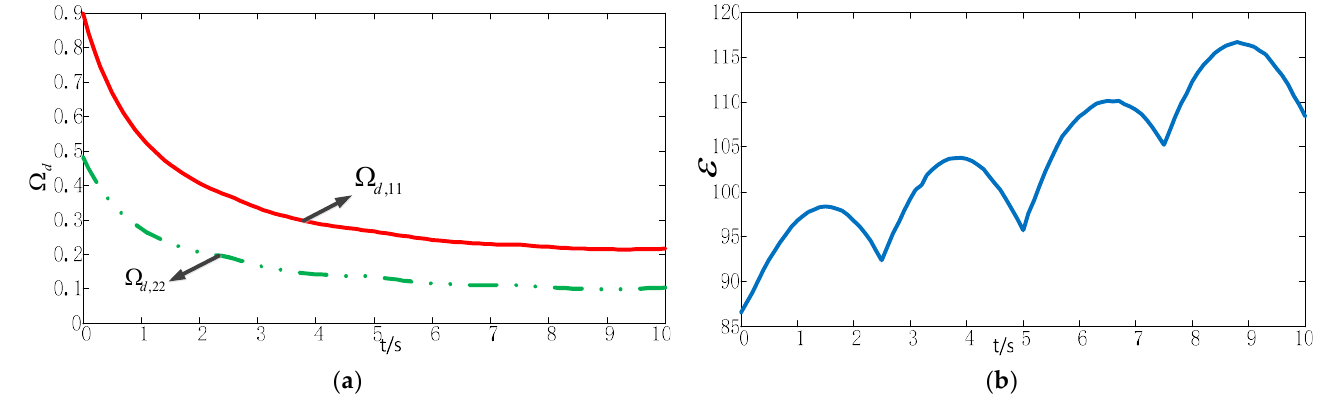
Figure 6. Comparison of the stability along the given spatial spiral trajectory when s = 1, t = 1 and s = 2, t = 2: ( a ) stability comparison; ( b ) stability difference influence index ε .